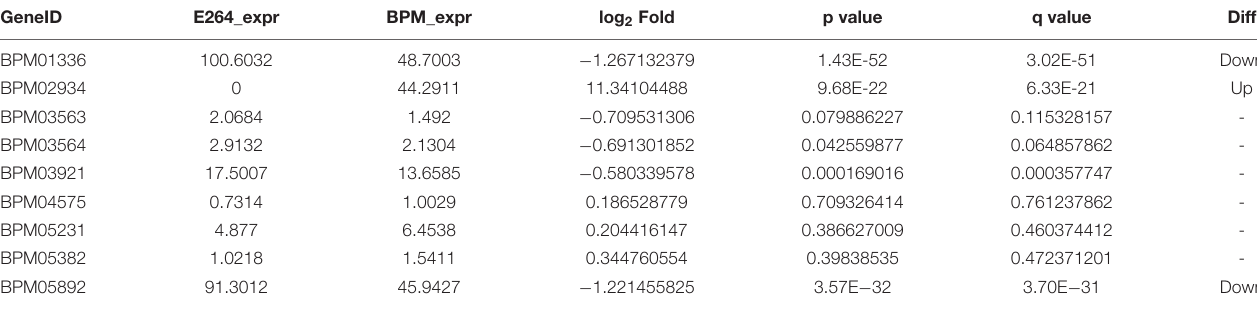
TABLE 2 | Expression of vgrG gene in BPM.